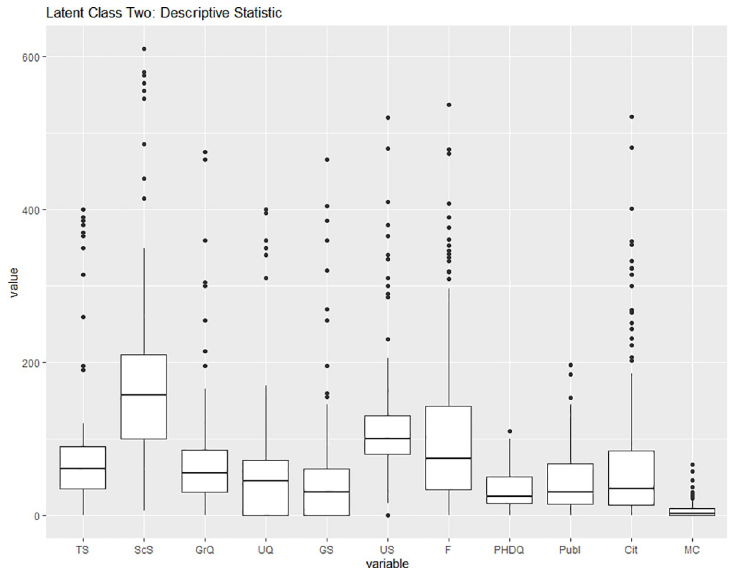
Fig 9. Descriptive statistic for latent class 2. Third Party Funding (F) and Material costs (MC) are displayed in 100k, while citations numbers (Cit) are displayed in tens. Source: own